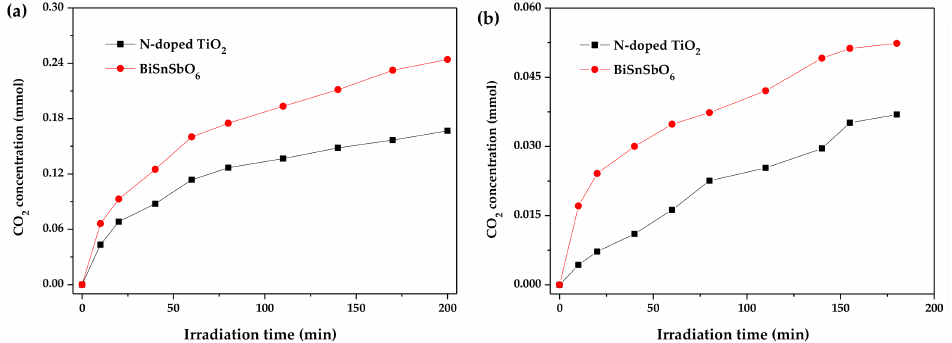
Figure 9. CO 2 generation during the RhB photodegradation ( a ) and the BZT photodegradation ( b ) over BiSnSbO 6 or N-doped TiO 2